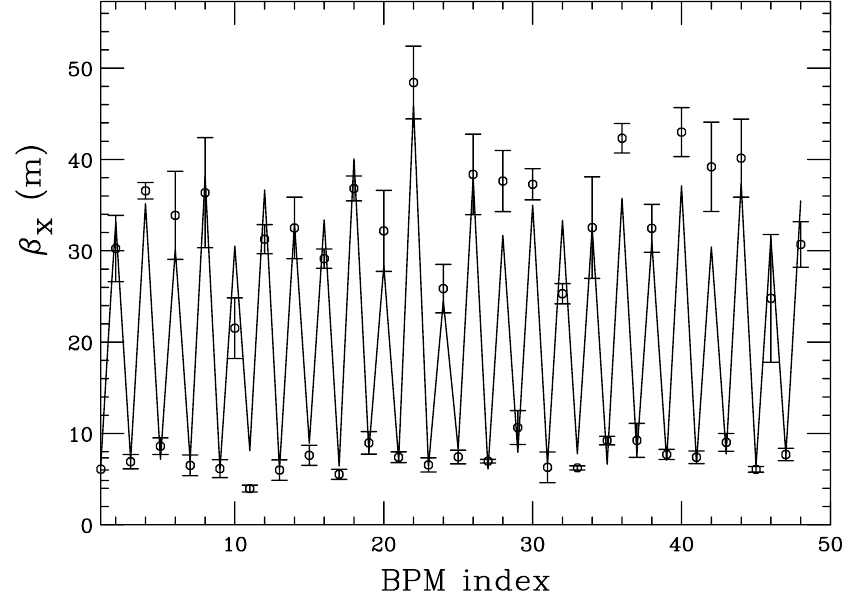
FIG. 8. Using the spatial function of two horizontal modes, one can calculate the betatron amplitude function at each BPM and phase advance between BPMs. The measured BPM is compared with the MAD model. The error bars were estimated with the standard deviation of the betatron function derived from the four data sets.